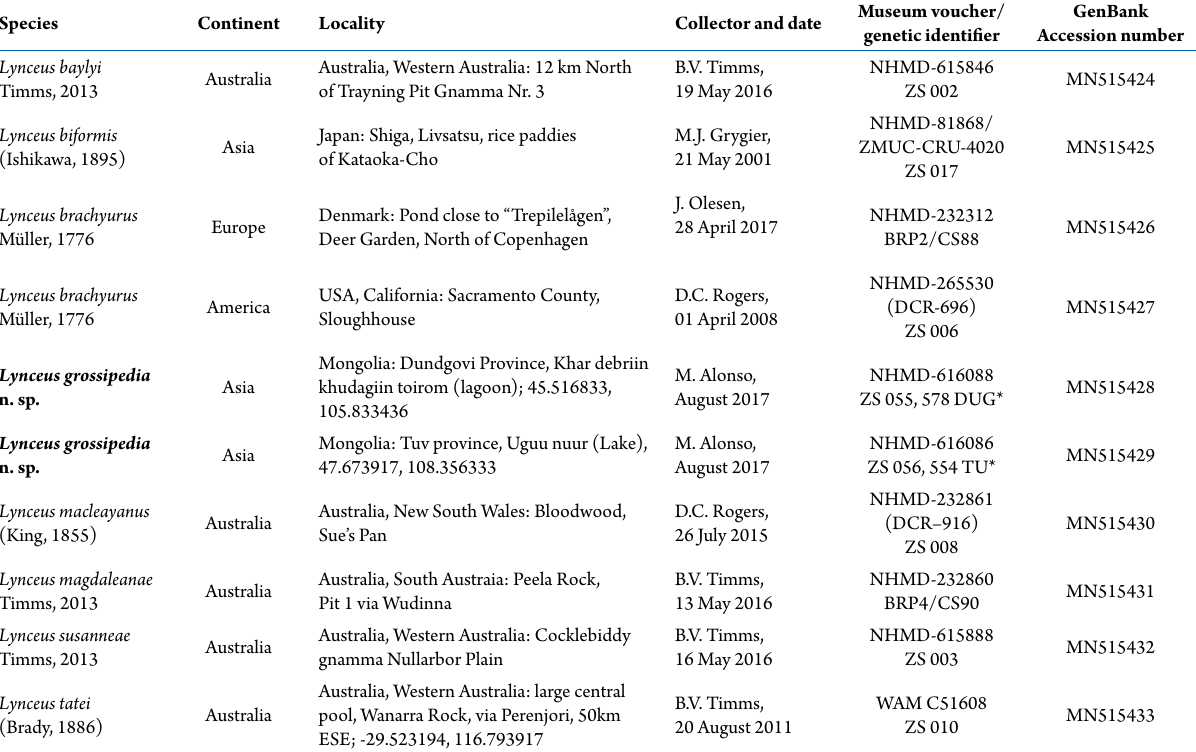
Table 1 . New COX1 sequences generated in the present study and used for DNA barcoding analyses. The material of the new species, Lynceus grossipedia n. sp., is highlighted in